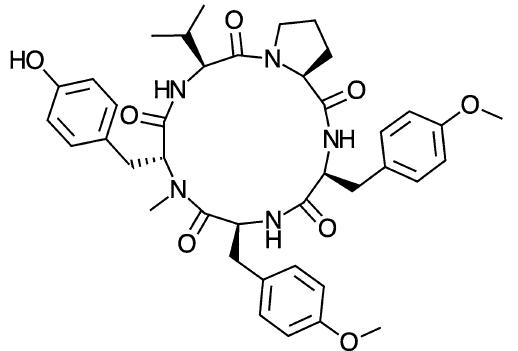
Figure 1. Graphical sketch of the molecular structure of the Aspergillipeptide D marine cyclopentapeptide.